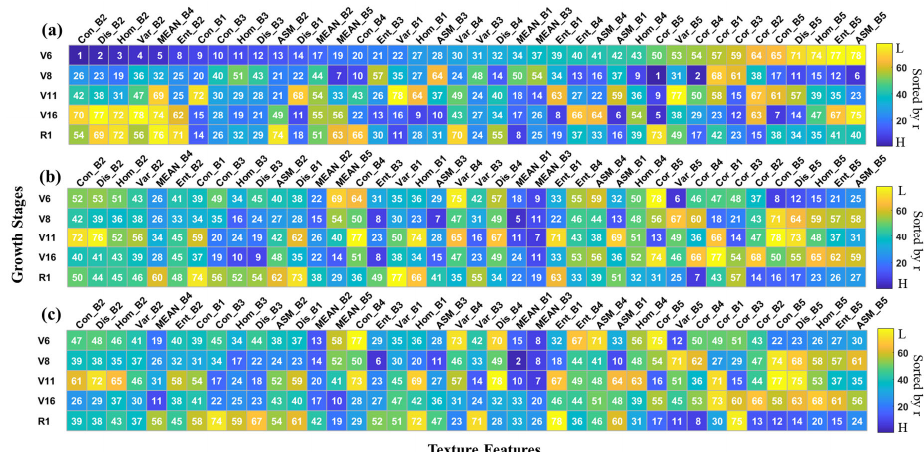
Figure 8. The ranking of the correlation between texture features and the target variables. ( a ) The ranking of the correlation between texture features and LCD. ( b ) The ranking of the correlation between texture features and LAI. ( c ) The ranking of the correlation between texture features and CCD. Note: The abscissa feature order of ( a – c ) is the descending order of the correlation between features and LCD at the V6 growth stage. The numerical value in the color bar represents the serial number of each feature. The smaller the serial number, the greater the r. For example, the number 1 represents the largest value of the r. H represents the high correlation; and L represents the low correlation. B1 represents the reflectivity of the first band of the multispectral image, and other similar. See Table 2 for the abbreviation of the texture feature.